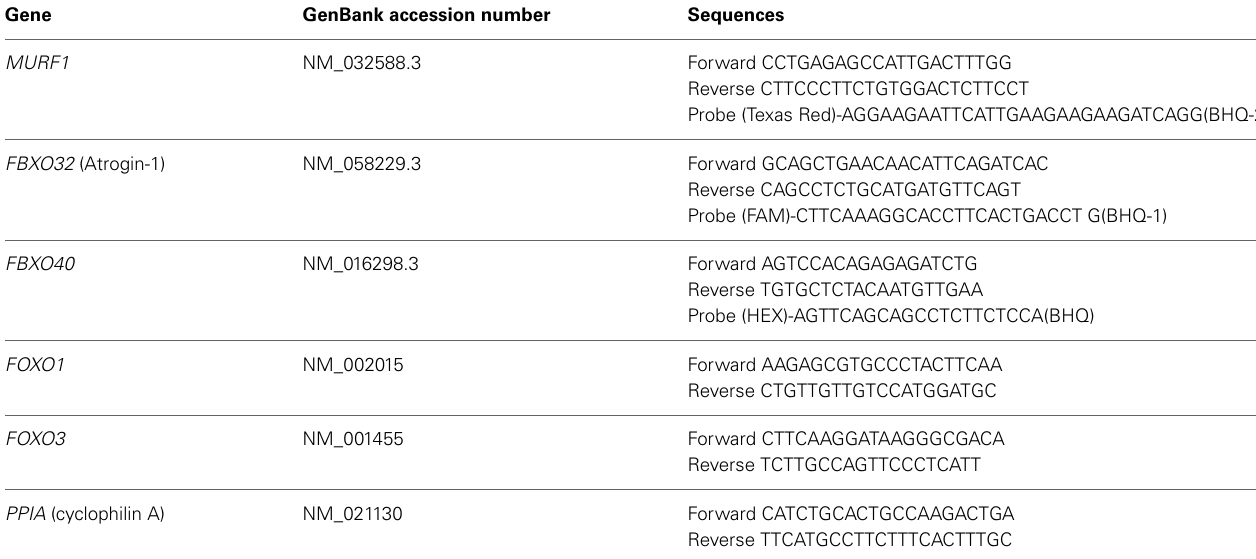
Table 1 | PCR human primer sequences.